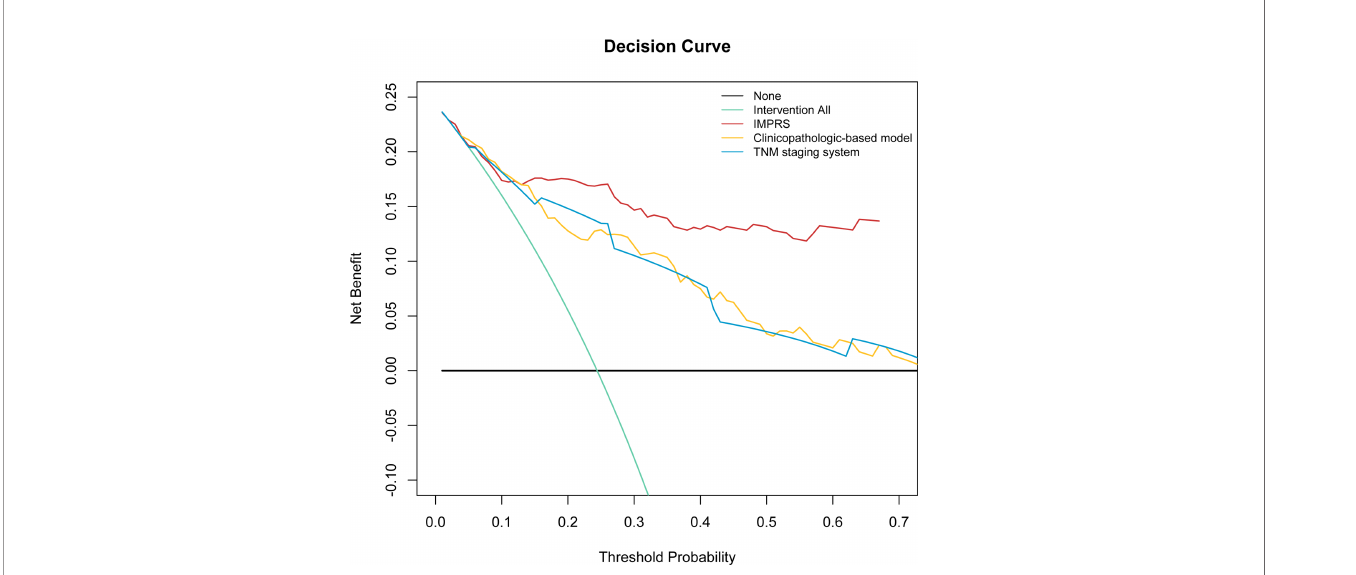
FIGURE 6 | Decision curve analysis for the comparison of the IMPRS (red line), clinicopathological-based model (orange line), and TNM staging system (blue line) in term of clinical usefulness. The y-axis measures the net bene fi